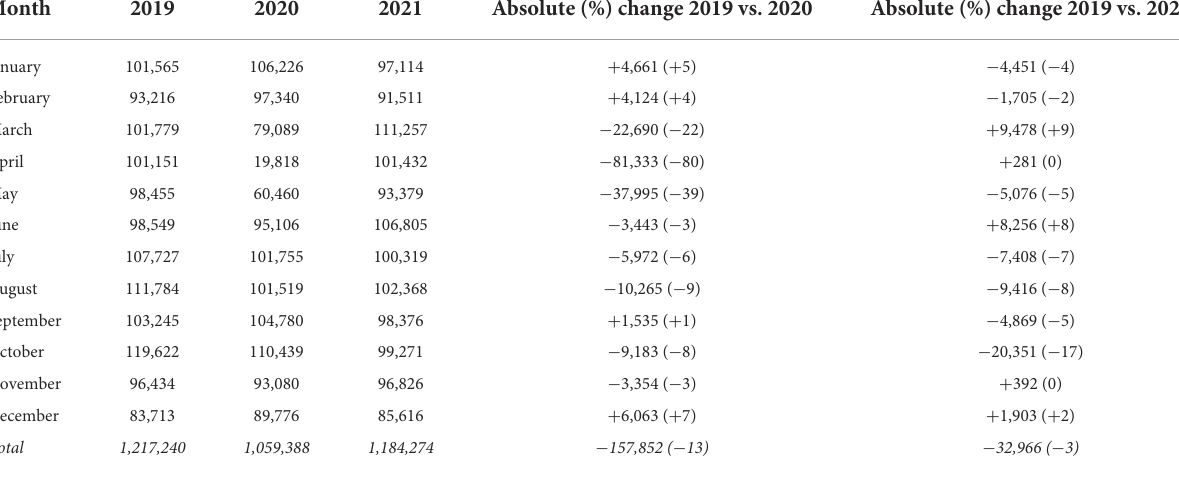
TABLE 1 Number of cats and dogs spayed or neutered, absolute change, and percentage change by month from January 2019 through December